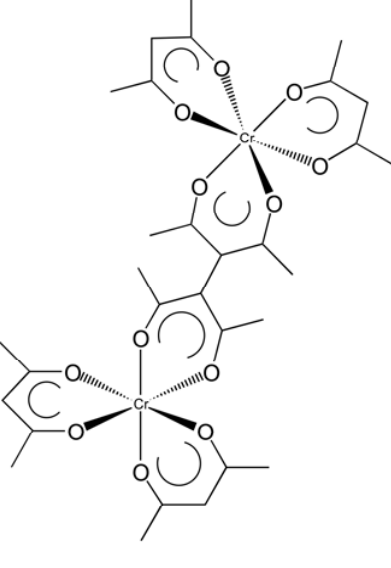
] oligomers and their HTP values in 3